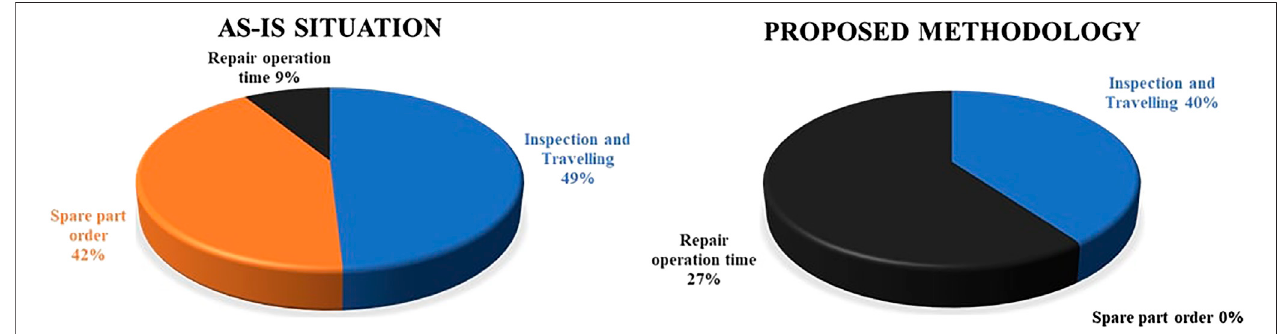
FIGURE 8 | Time distribution per task, as-is situation vs proposed